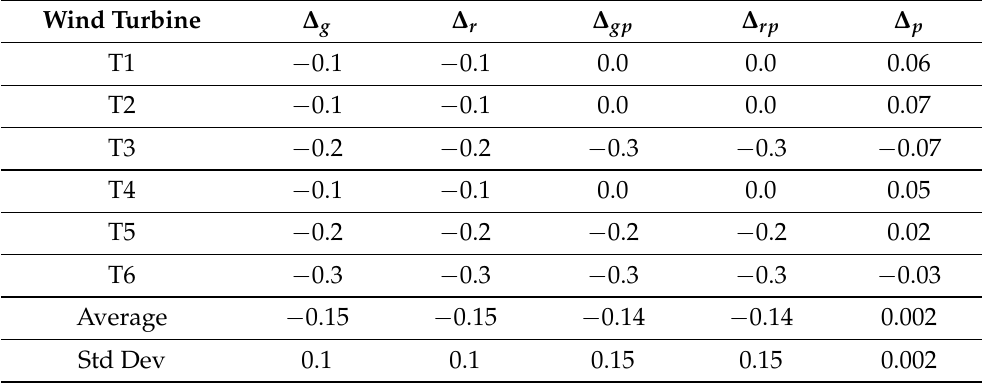
Table 6. Estimates of the average percentage energy yield decline with age for the considered working region and operation curves: WF1. ∆ g and ∆ gp (respectively, ∆ r and ∆ rp ) quantify the average percentage energy yield change due to the decrease in extracted power for a given generator (respectively rotor) speed in Region 2; ∆ p quantifies the same quantity as a function of the blade pitch in Region 2 1 / 2 . The metrics are computed according to Equation